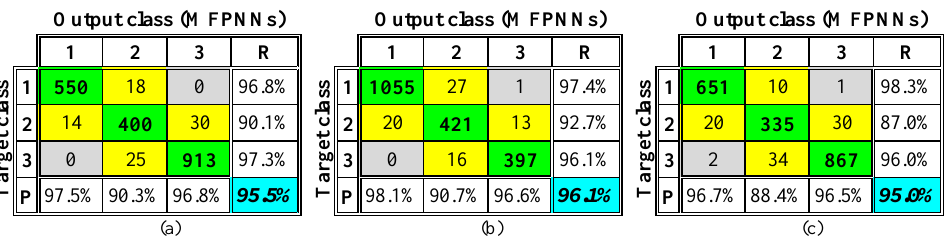
Figure 15. CMs of the classifications performed by the MFPPNs embedded in the current version of the software application ( a ) for BB, ( b ) for FIB, and ( c ) for PB.